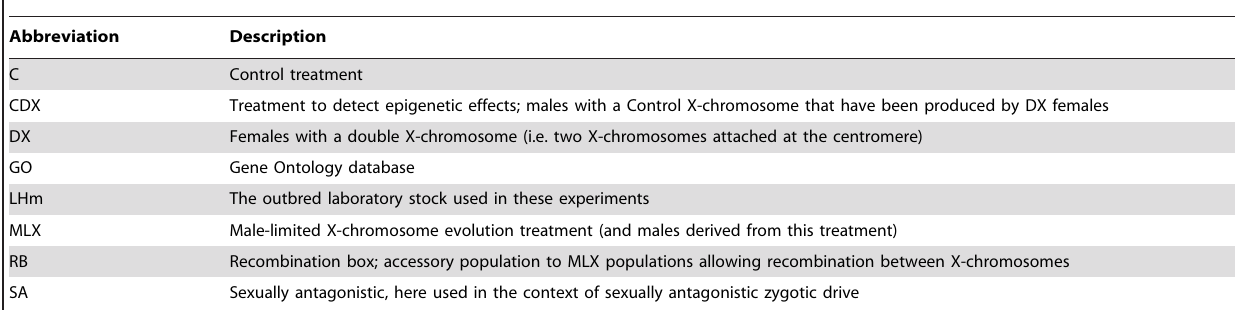
Table 1. List of abbreviations used in this paper.